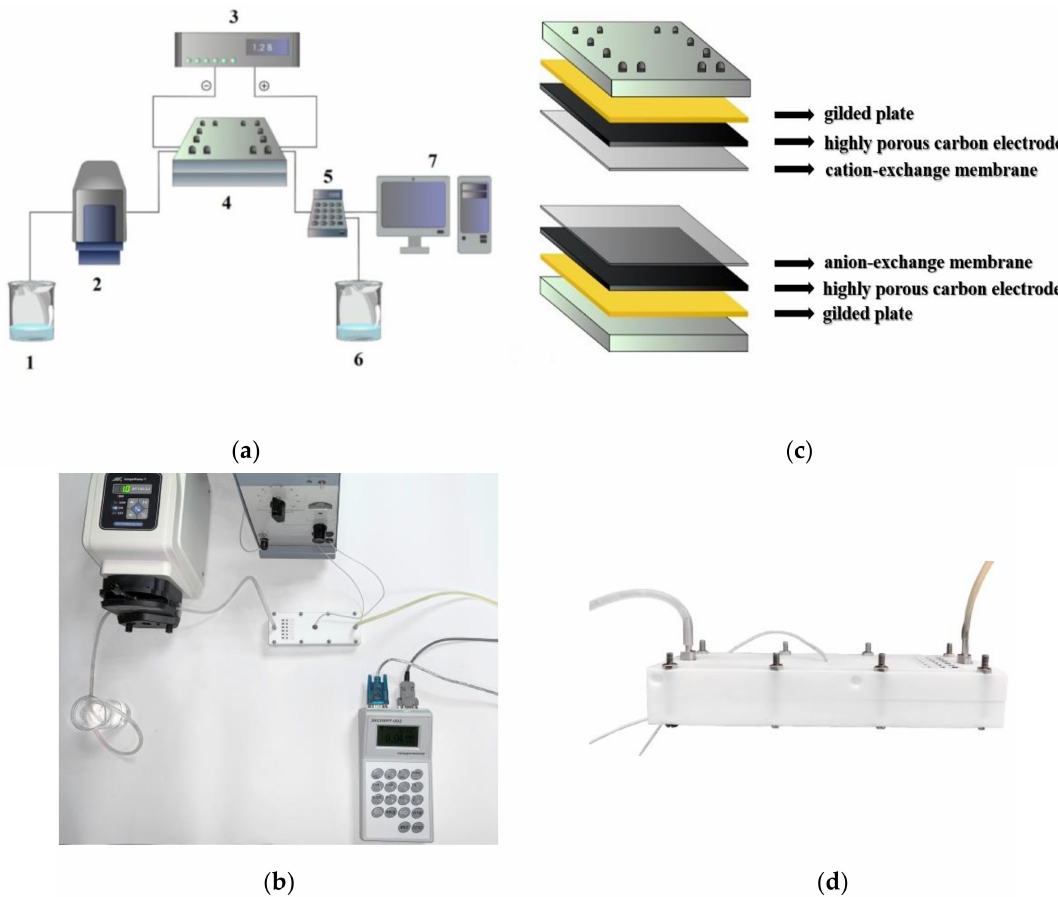
Figure 9. Scheme ( a ) and photo ( b ) of laboratory setup: 1 —salt solution; 2 —peristaltic pump; 3 —potentiostat; 4 —cell; 5 —conductivity; 6 —e ffl uent; and 7 —computer; scheme ( c ) and photo ( d ) of electrochemical